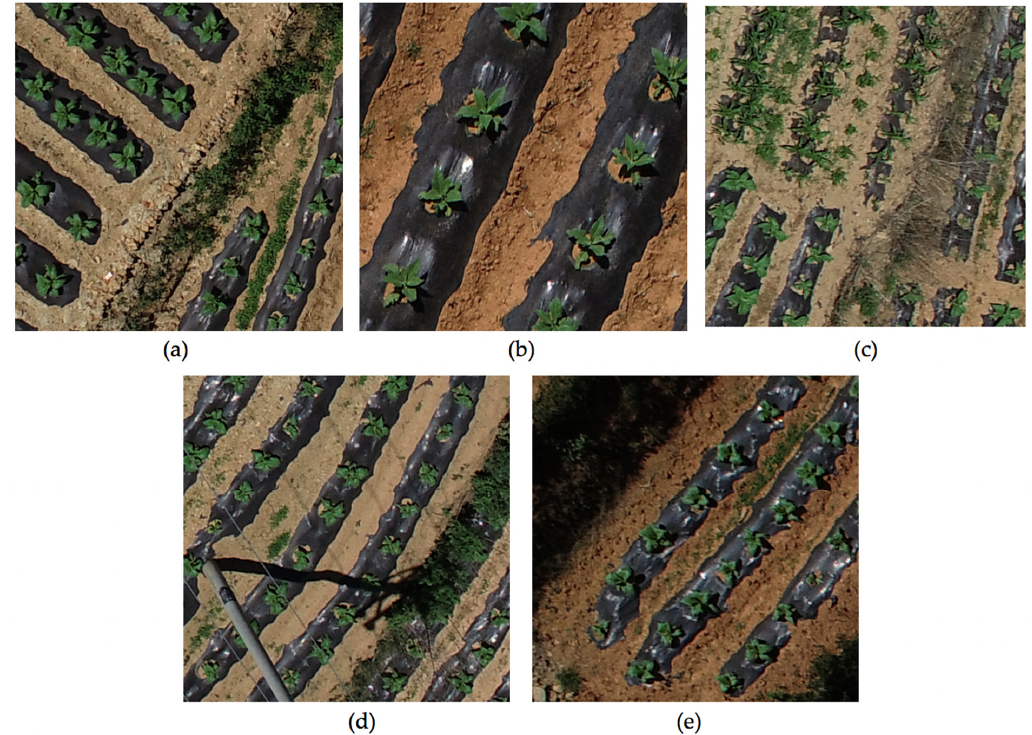
Figure 2. An overview on the datasets. ( a – e ) Come from dataset 1–5, respectively.